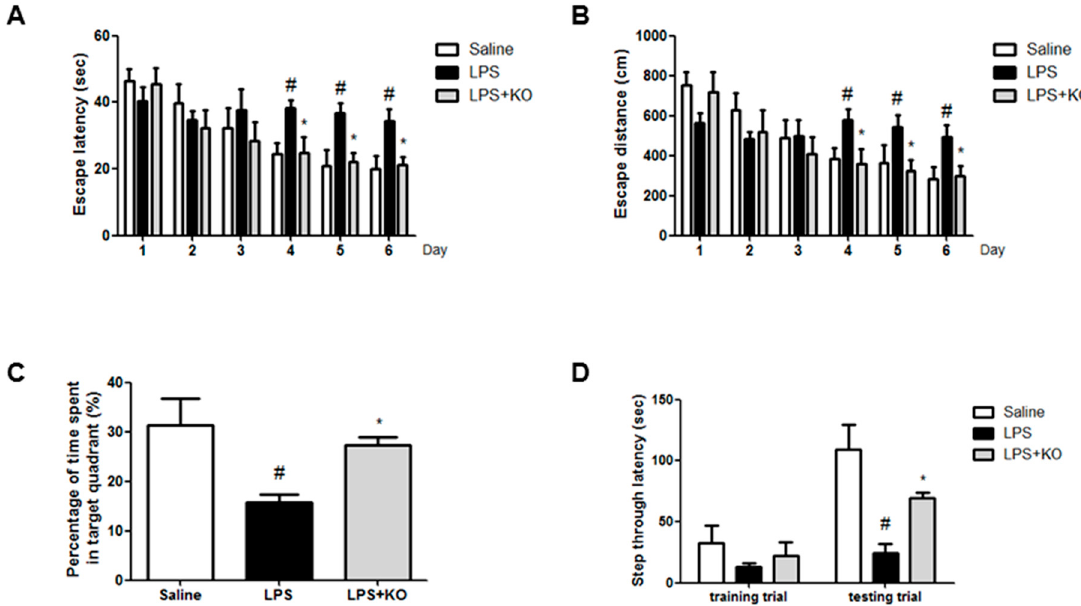
Figure 1. Effect of Krill oil on memory impairment. To investigate the effect of Krill oil in LPS-induced memory impairment, we performed: a water maze test ( A , B ); a probe test ( C ); and a step-through type passive avoidance test ( D ). Memory function was determined by the escape latencies ( A , s) and distance ( B , cm) for 5 days, and time spent in the target quadrant ( C , %) in the probe test after administration of LPS. Each value is mean ± Standard deviation (SD) from eight mice. Group differences were analyzed by one-way ANOVA followed by Bonferroni’s post-hoc analysis. # Significantly different from control group ( p < 0.05). * Significantly different from LPS-treated group ( p < 0.05).